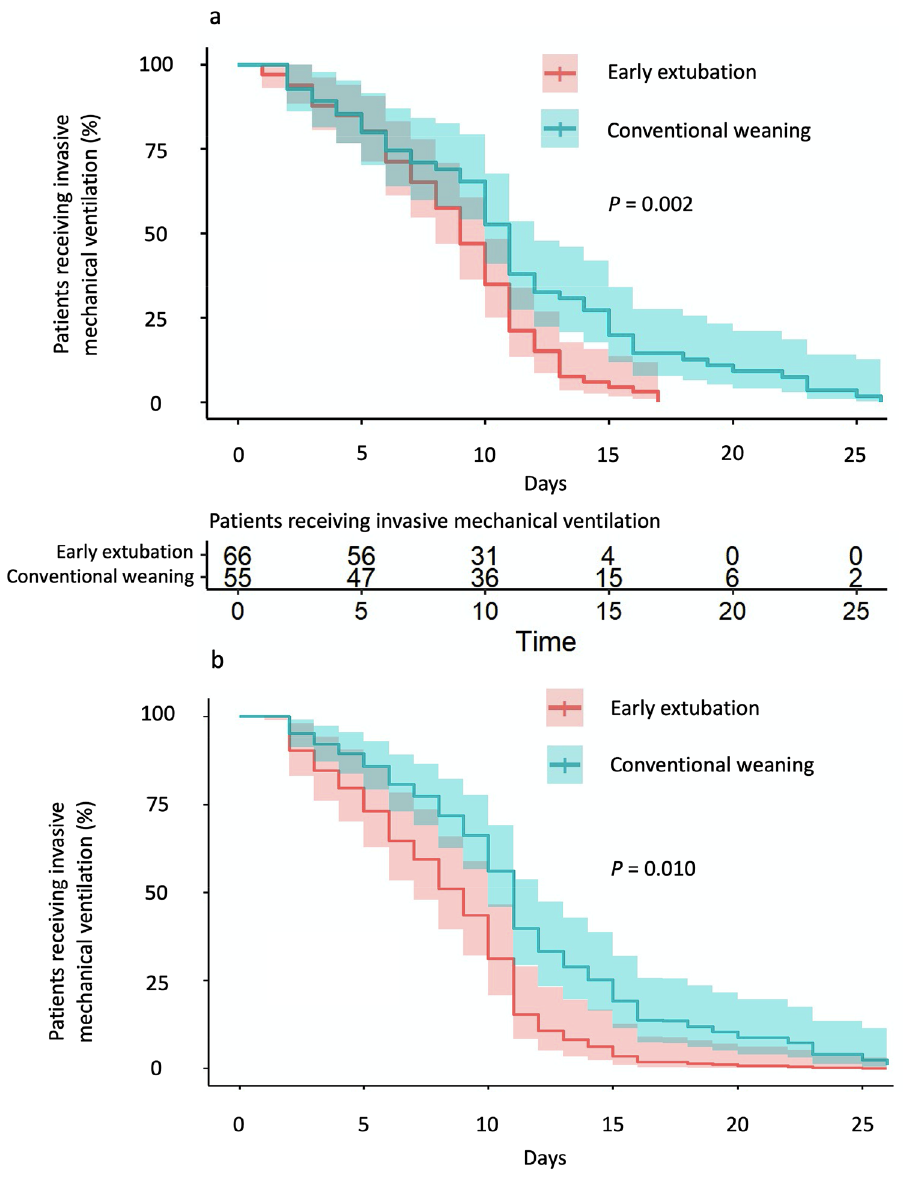
Figure 2. Kaplan–Meier curves indicating the time lag from intubation to IMV discontinuation. The Kaplan– Meier curve showing median and interquartile range are depicted: red line represents early extubation group while turquoise line refers to standard weaning group; P values refer to Log-Rank test. Kaplan–Meier curve constructed without ( a ) or with adjusting for propensity score ( b ).